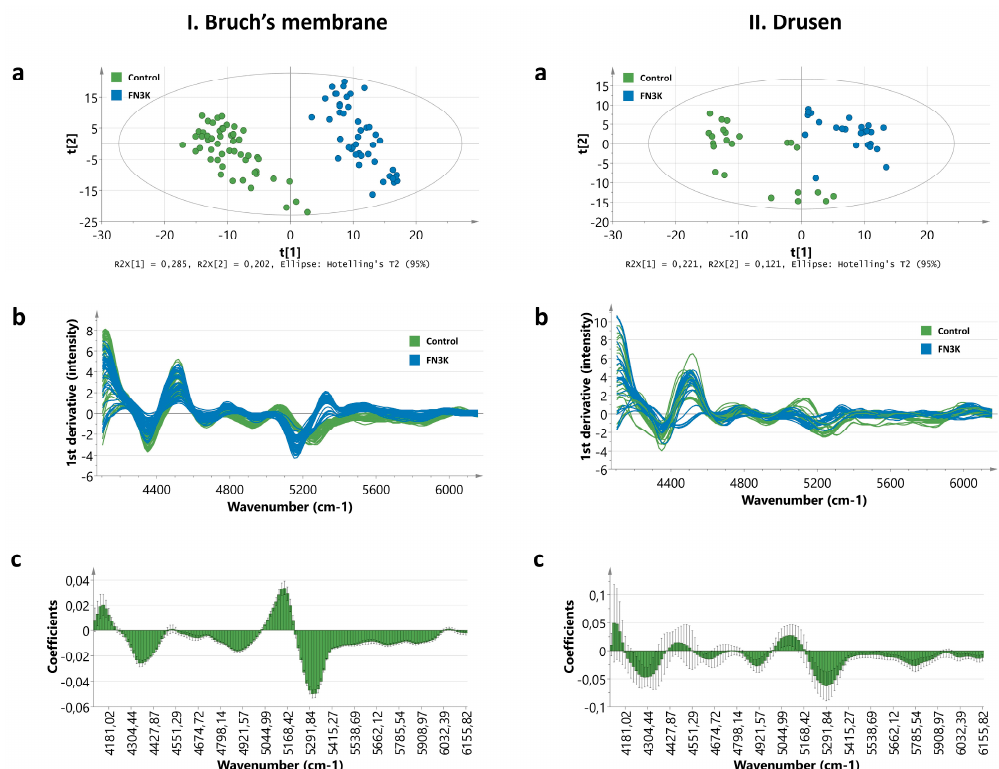
Figure 5. Near-infrared (NIR) microspectroscopy of the Bruch’s membrane ( I ) and drusen ( II ) on hematoxylin and eosin stained slides originating from two patients with stage 3 AMD. ( a ) Score plot showing clear clustering of the control-treated (green dots) and fructosamine-3-kinase (FN3K)-treated (blue dots) Bruch’s membrane and drusen based on principal component analysis (PCA) of the first derivative of the full spectral range (12,000 to 4000 cm -1 ). ( b ) Spectral differences in the first derivative of the 4000–6150 cm -1 range between the control-treated (green lines) and FN3K-treated (blue lines) Bruch’s membrane and drusen. ( c ) Coefficient plots resulting from partial least squares discriminant analysis (PLS-DA) of the 4000–6150 cm -1 range. The coefficients express how strongly the wavenumbers contribute in the discrimination between the control and FN3K-treated Bruch’s membrane and drusen.